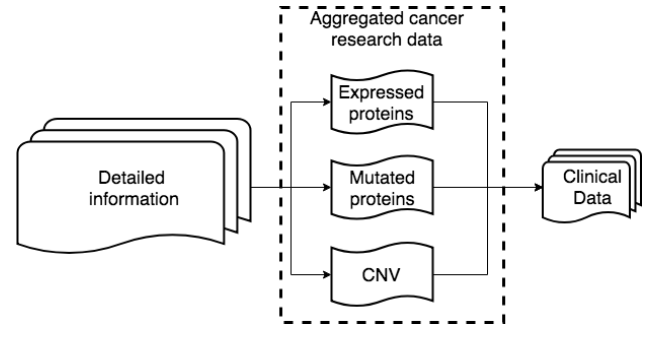
Figure 1. Raw data